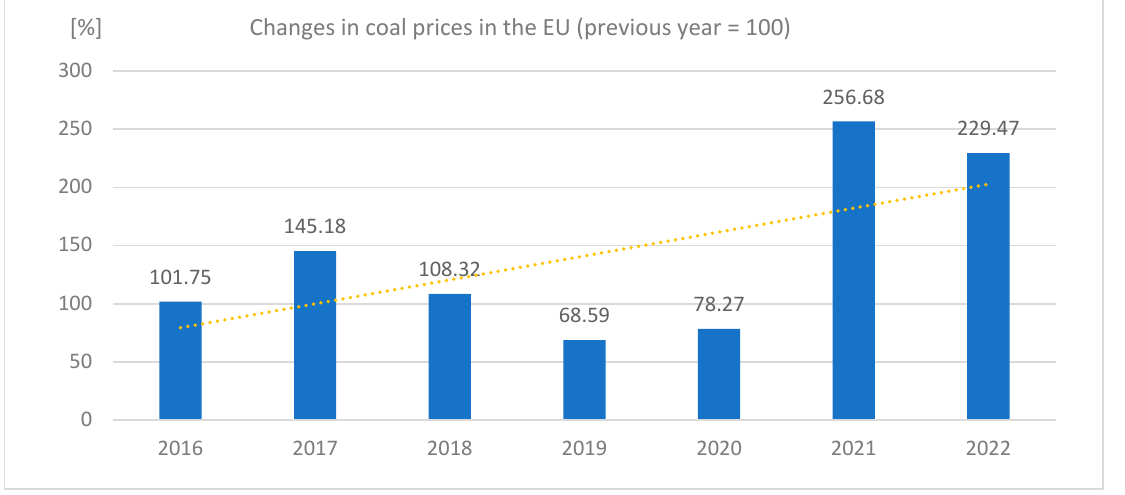
Figure 6. Changes in coal prices on the Rotterdam stock exchange between 2015 and 2022. Source: Authors’ original compilation based on [82].